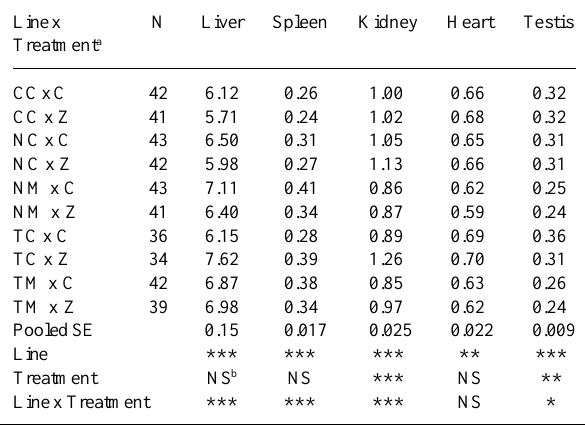
Table II - Least-squares means and SE for line by treatment subclasses and ANOVA significance levels of organ weights as a percentage of 8-week body weight (%).